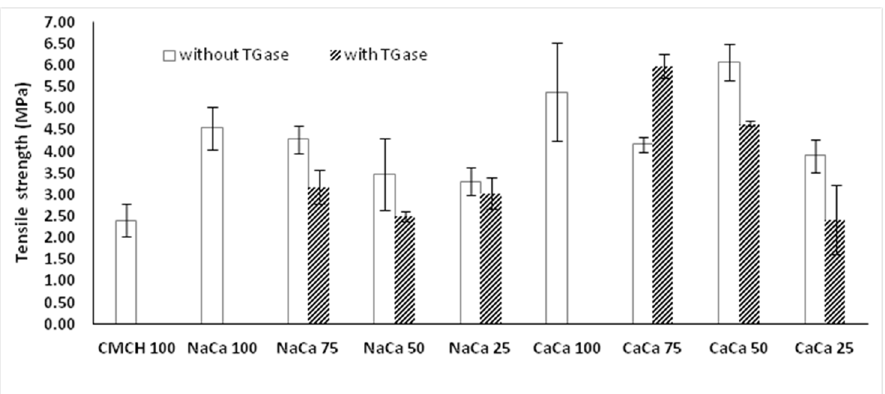
Figure 1. Tensile strength of CA-CMCH composite films [CHCH = carboxymethyl chitosan; NaCA = sodium caseinate, CaCA = calcium caseinate, 100, 75, 50, and 25 represent the proportion of the individual component, the balance out of 100 being CMCH].